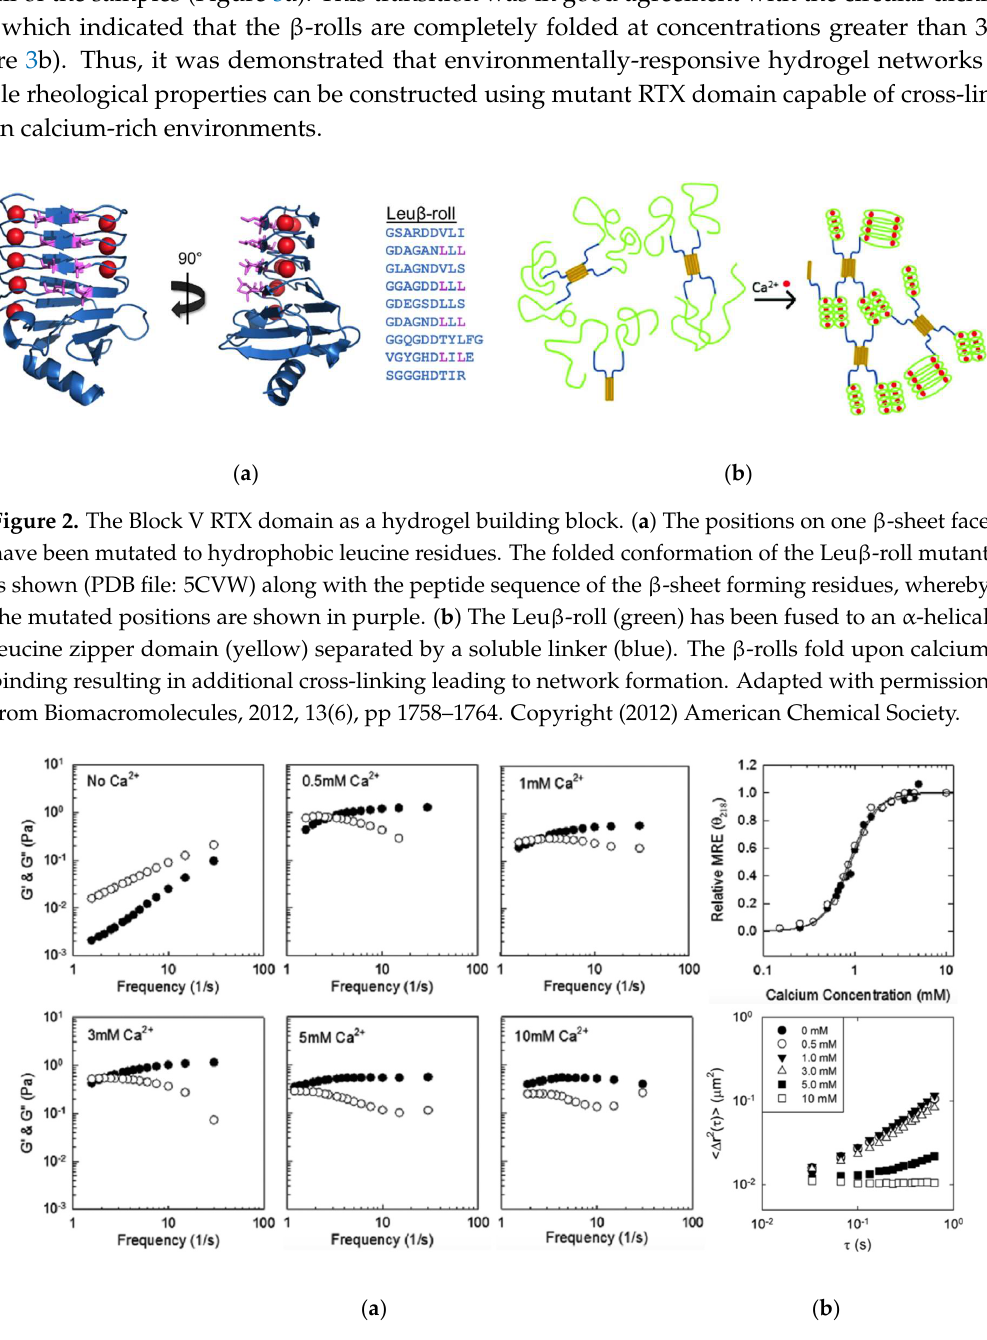
Figure 3. Calcium dependent tuning of the rheological properties of RTX-domain hydrogels. ( a ) Microrheology data of H-S-Leuβ-roll calcium titration with viscous (o) and elastic (●) moduli, showing the transition from viscous sample to elastic hydrogel with increasing calcium concentrations; ( b ) Top panel: circular dichroism data of the WTβ-roll (●) and the Leuβ-roll (o) indicating complete folding at calcium concentrations larger than 3 mM. Bottom panel: Time averaged mean square displacement (MSD) measurements of H-S-DLeuβ-roll calcium titration. A linear increase in MSD with respect to lag time was observed at low calcium concentrations, whereas a plateaued MSD profile indicated hydrogel formation. Adapted with permission from Biomacromolecules, 2012, 13(6),